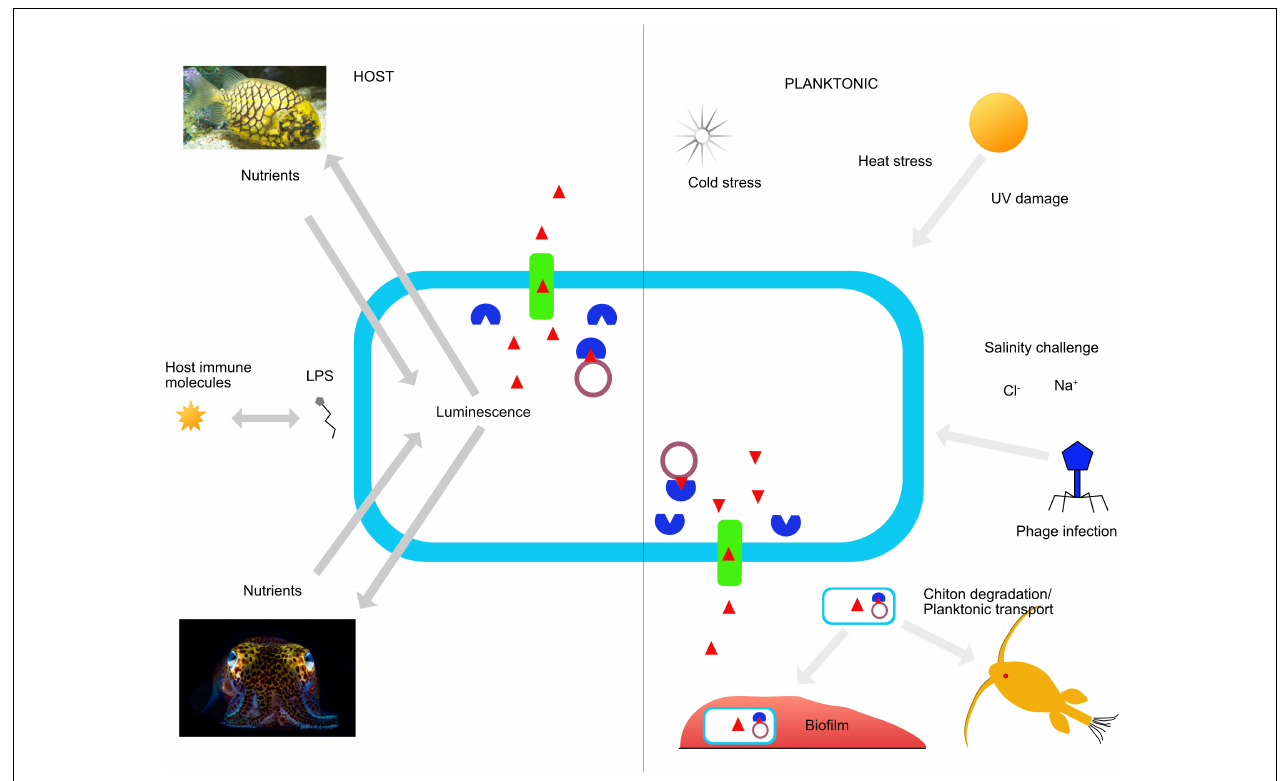
FIGURE 1 | Response to environmental cues inside and outside the host by V. fischeri . A diagrammatic representation of the various impacts and responses that V. fischeri endures as a result of planktonic or host associated factors. Some mechanisms are universal, but induce different responses according to the environmental context. One example is quorum sensing, used for light generation and host immune response suppression inside a host, while these same signaling and response pathways are employed planktonically to ensure survival and persistence when nutrients are limiting. Host factors drive specificity among certain ecotypes of V. fischeri , thus creating a hierarchy of diverse strains that range in host compatibility. See Figure 2 for